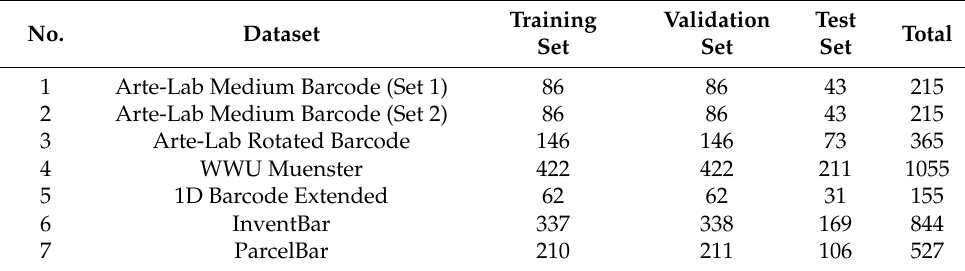
Figure 2. Image of the training data corresponds to the InventBar and ParcelBar and their respec- tive annotations. Table 5. General information of the benchmarked datasets and